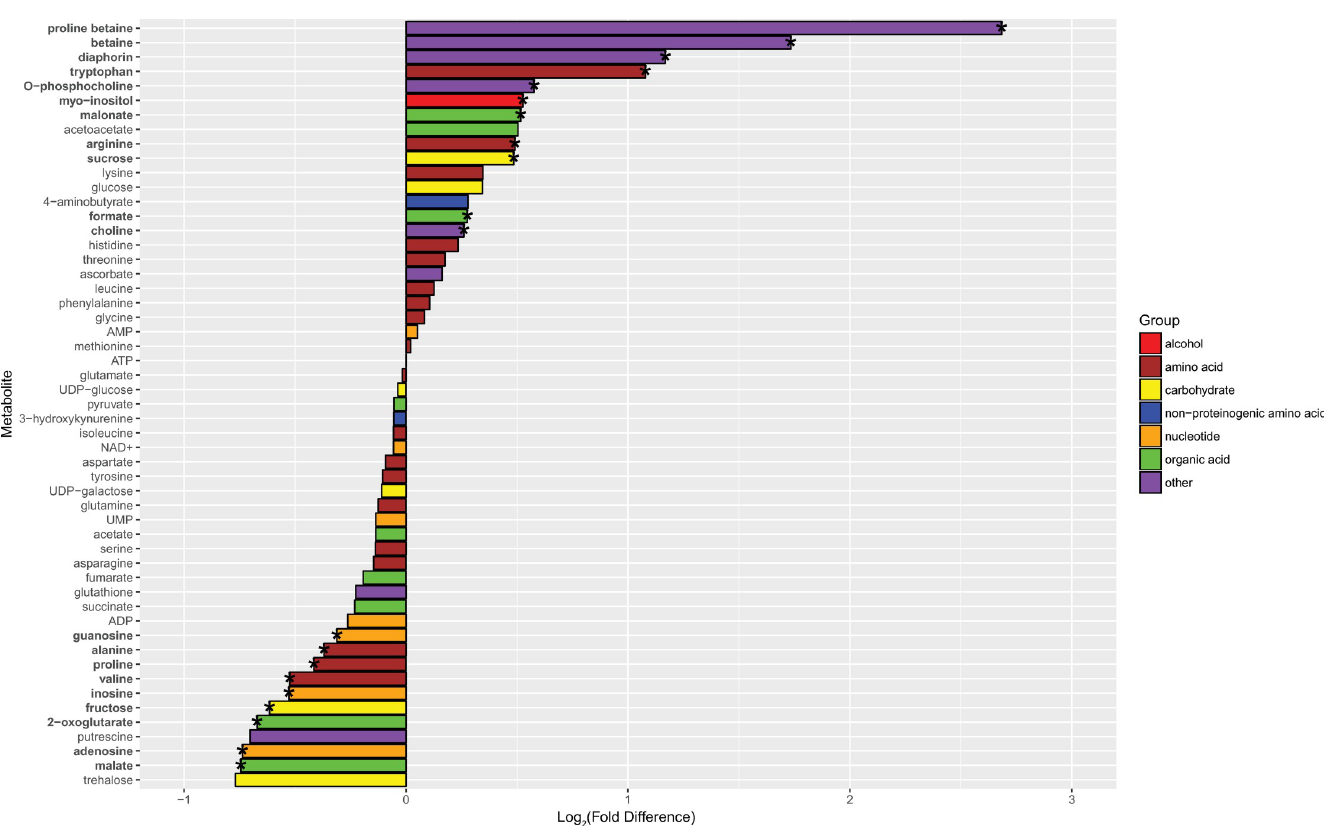
Fig 6. Metabolite log 2 -fold differences between control and CLas-exposed females. Positive fold differences indicate a higher concentration in CLas-exposed females, while negative fold differences indicate a higher concentration in control females. Metabolites in bold and corresponding bars with an asterisk are significantly differentially abundant between control and CLas-exposed females. Metabolites are colored by type of